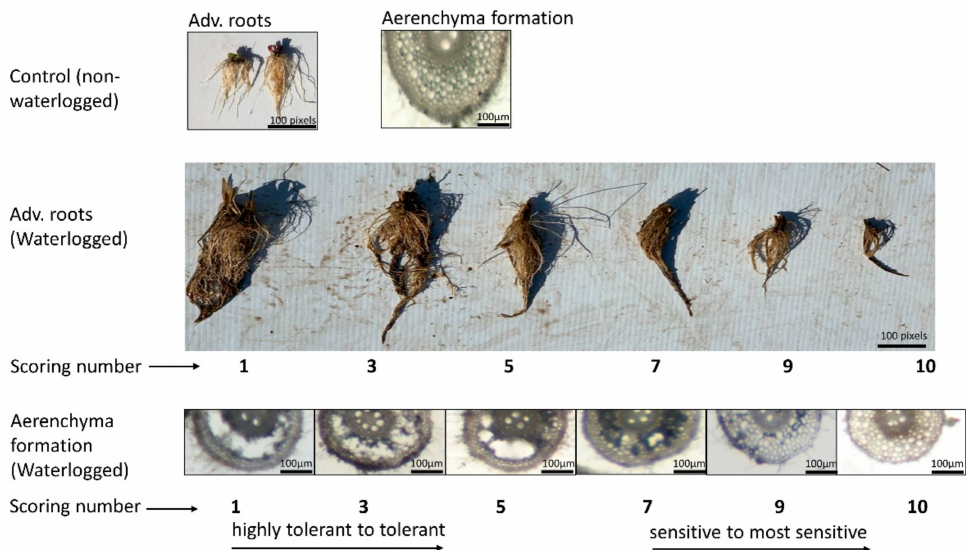
Figure 1. Adventitious root and aerenchyma formation under control and waterlogged conditions. Under control conditions, adventitious roots were not affected, and no aerenchyma was formed. However, under waterlogging conditions, adventitious roots were affected, and aerenchyma was formed. Waterlogging tolerance was divided into four levels: highly tolerant (score 1–3), tolerant (score above 3–5), sensitive (score above 5–7), and highly sensitive (score above 7–10).